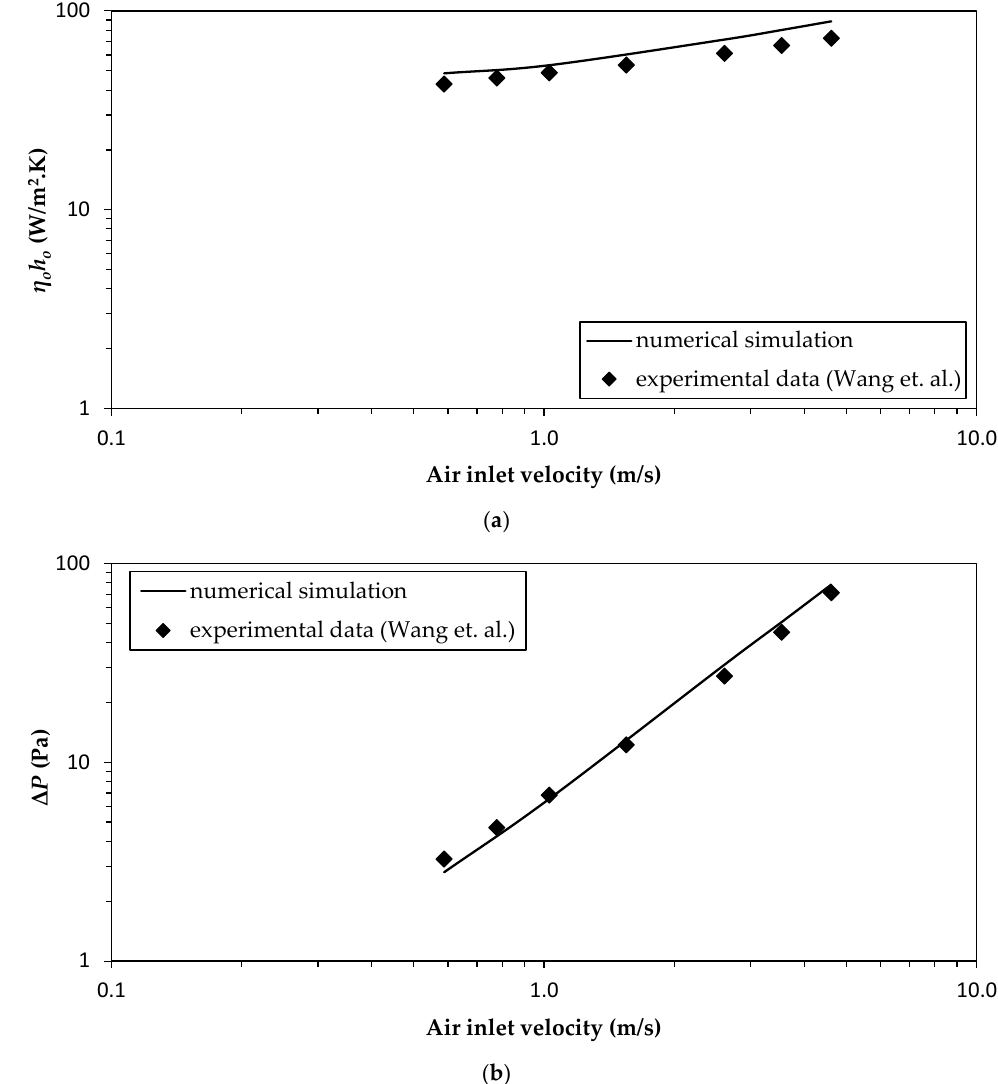
Figure 3. Comparison of numerical and experimental results done by Wang et al. [31]: ( a ) Thermal conductance; ( b ) Pressure drop.